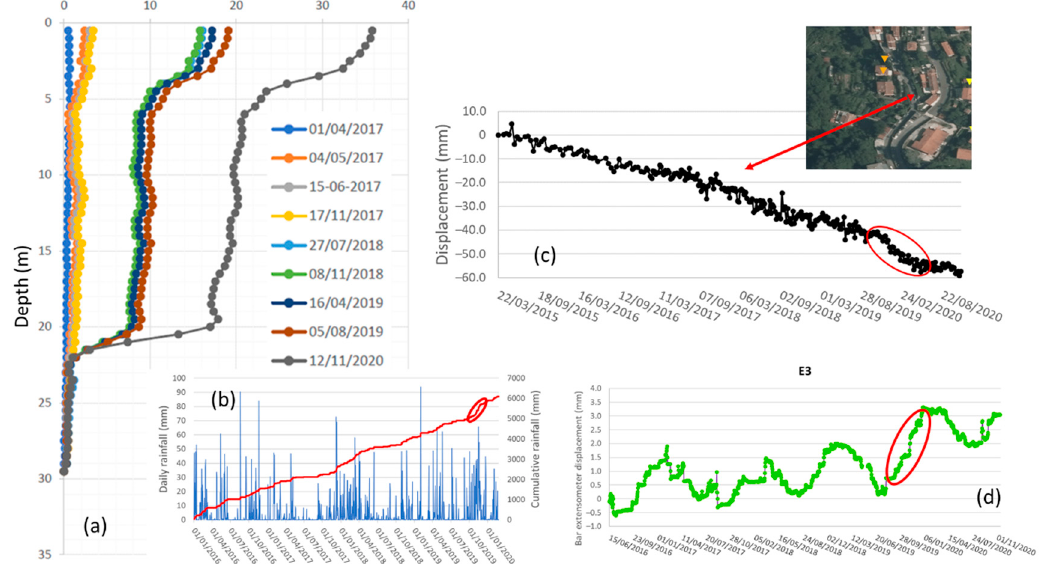
Figure 15. Example of an acceleration period between October and November 2019 and recorded by the inclinometer ( a ), MT-InSAR data ( c ), and extensometer ( d ), that was triggered by heavy rainfall ( b ). Red arrow ( a ) and red ellipses ( b , c and d ) highlight the period between October and November 2019.